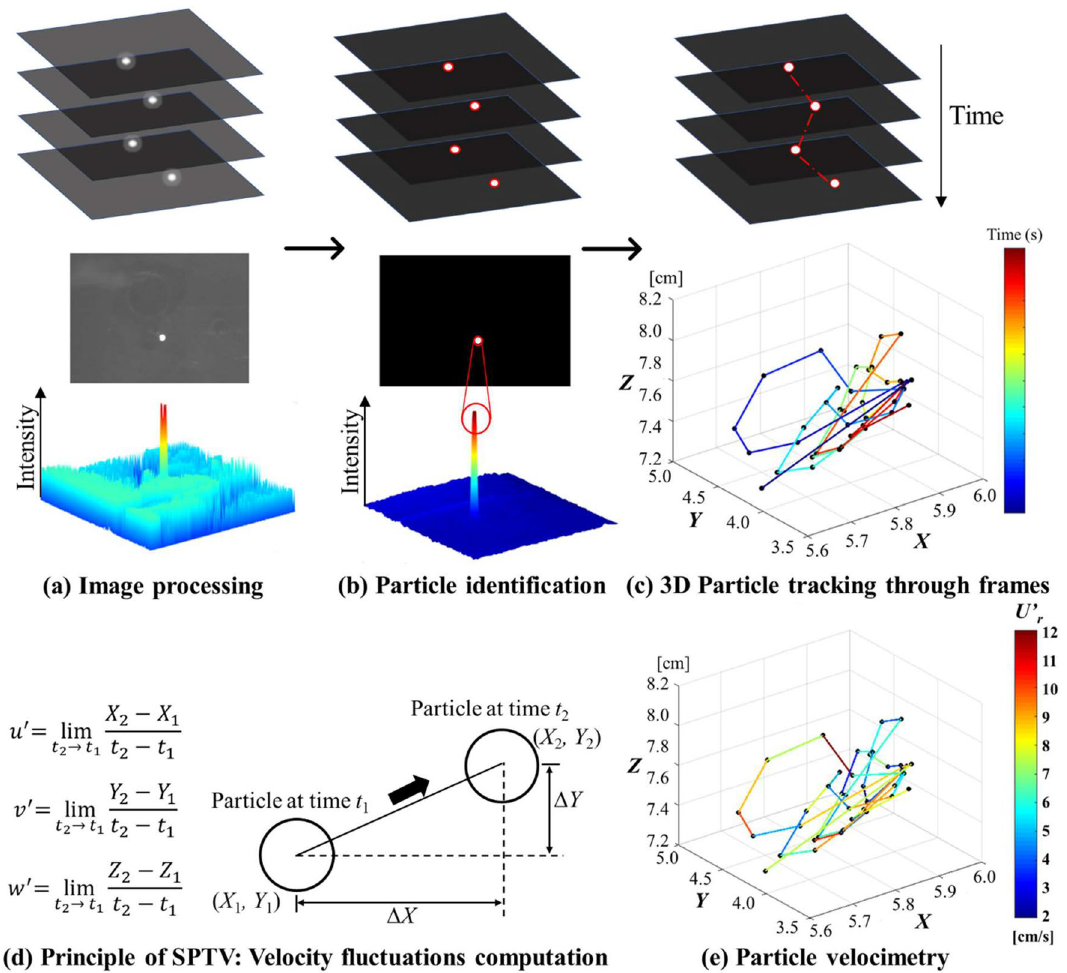
Figure 3. Overview of SPTV workflow: ( a ) image processing including image un-distortion, background subtraction and threshold-based binarization, ( b ) particle identification and centroid determination, ( c ) 3D reconstruction and particle trajectory (image frame 1 to image frame 40), ( d ) the fundamental principle of SPTV: velocity fluctuations computation, and ( e ) 3D particle velocimetry (image frame 1 to image frame